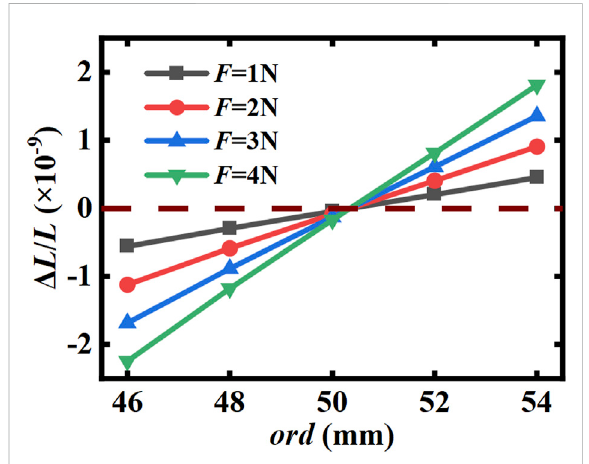
Relationship between O-ring diameter and relative axial displacement of the cavity mirror center for different extrusion forces without compensation ring.